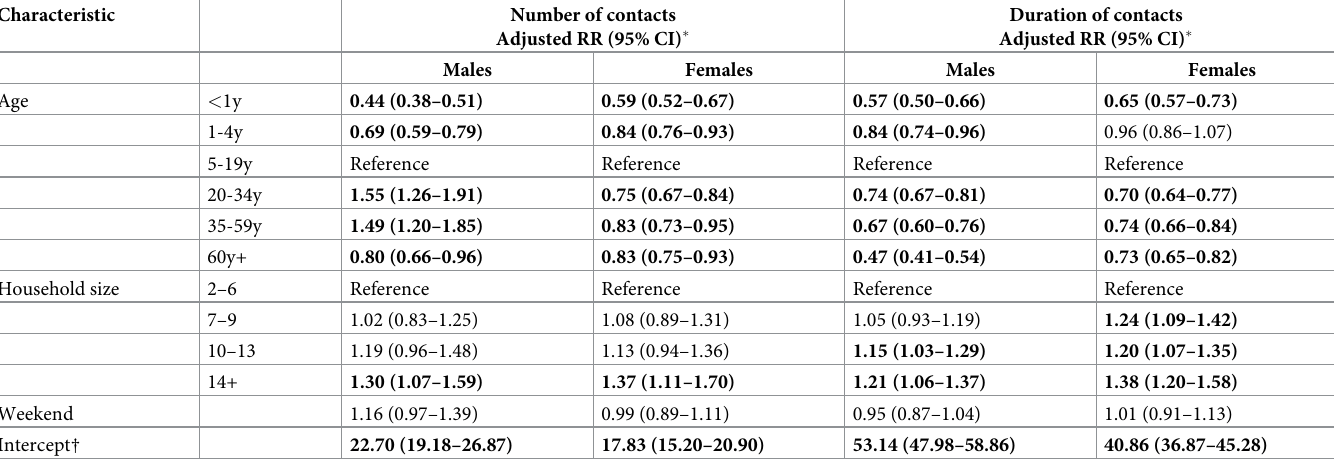
Abbreviations: RR, rate ratio; CI, confidence interval. Bold numbers are adjusted rate ratios significant with p-value < 0.05. � Values are exponentiated coefficients from a negative binomial model adjusting for age group, household size group, and weekend/weekday, and accounting for clustering in